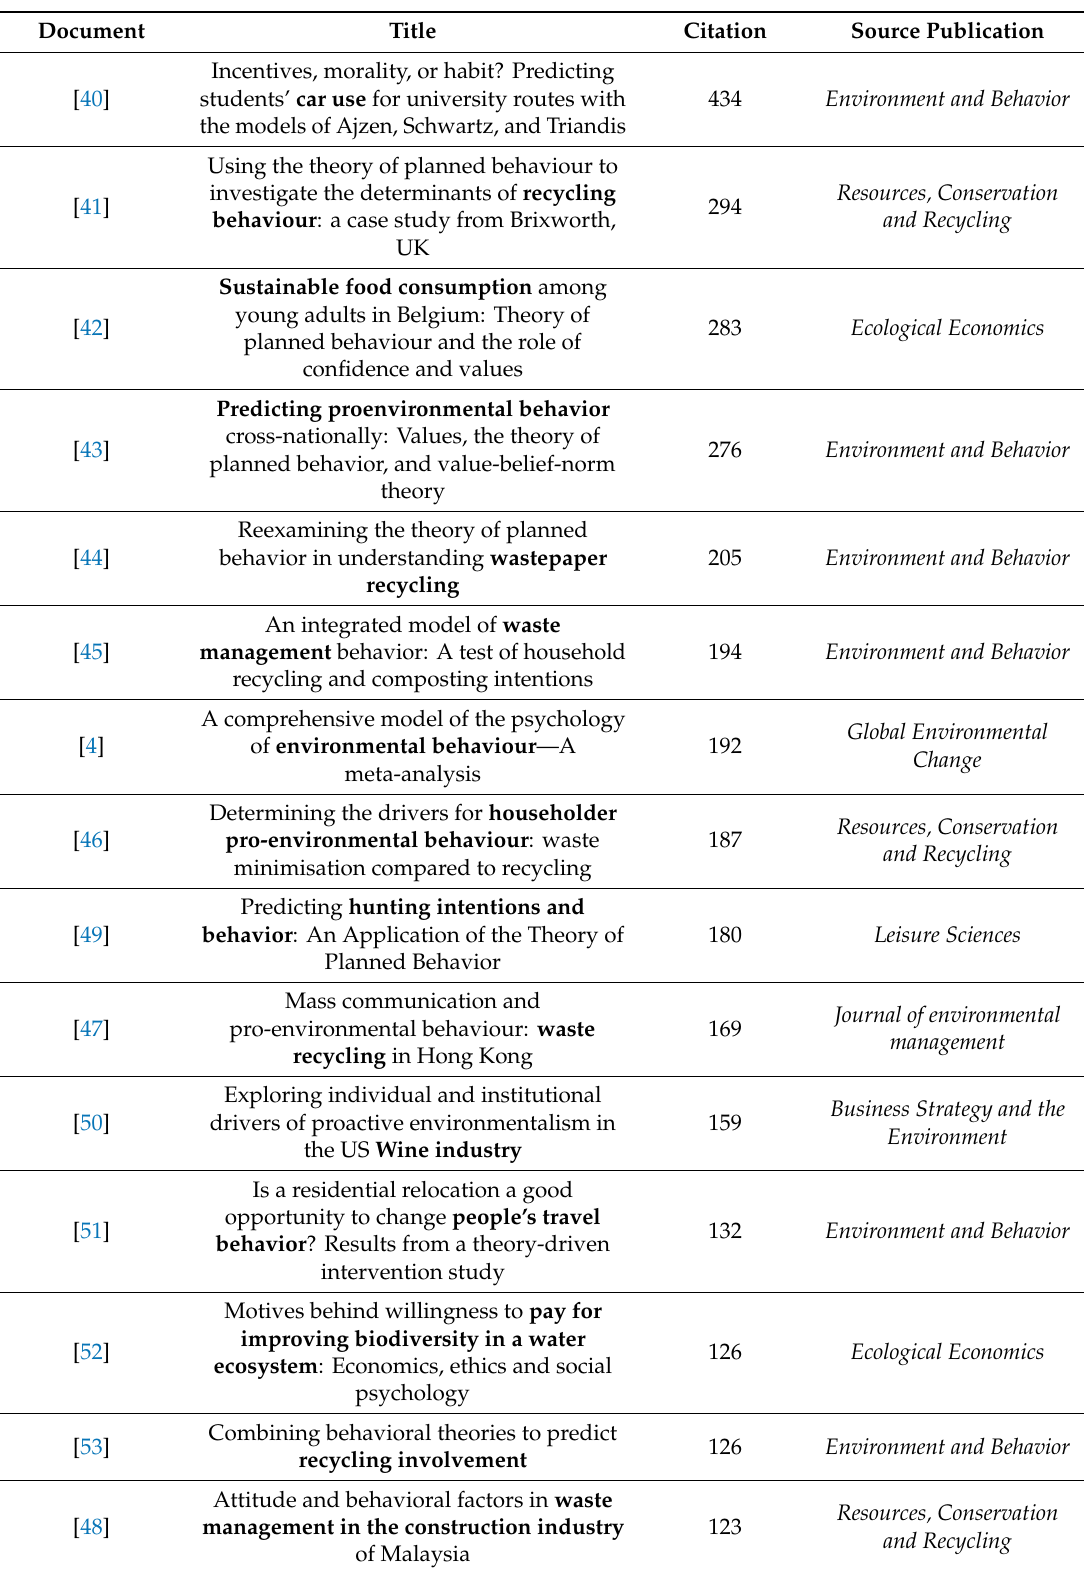
Table 3. The top 15 cited articles applying the TPB to environment